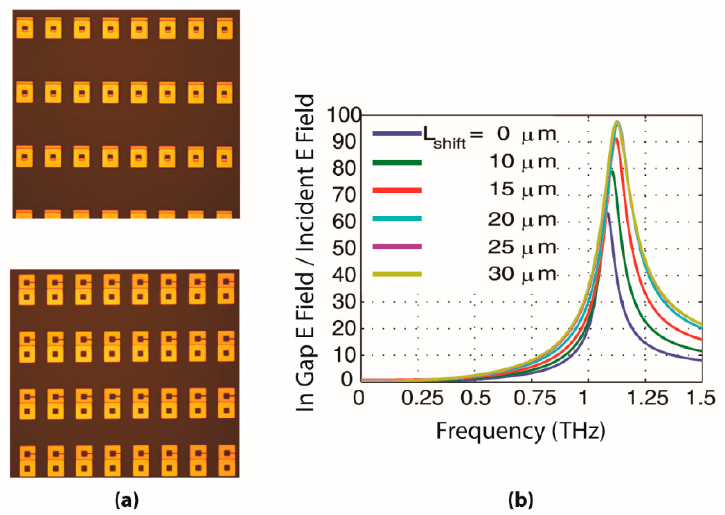
Figure 2. Example of structural tuning of field confinement in a split ring resonator. ( a ) Photograph of a metamaterial consisting of a SRR array below a closed conducting ring array. ( b ) Inducing an in-plane shift between the two layers, results in a 40% increase to the magnitude of the electric fields confined in the SRR gap. Reproduced from [36] .